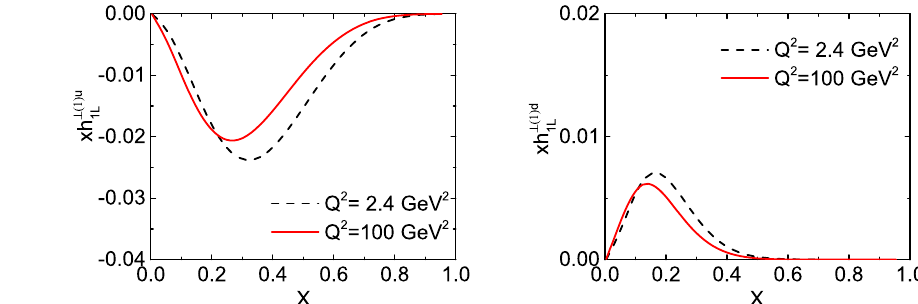
( x , Q 2 ) Fig. 2 Left panel: h ⊥ ( 1 ) 1 L (multiplied by x) of the proton longitudinal transversity PDF h ⊥ for up quark at 1 L Q 2 = 2 . 41 GeV 2 and Q 2 = 10 GeV 2 . Right panel: similar to the left panel, but for the down quark